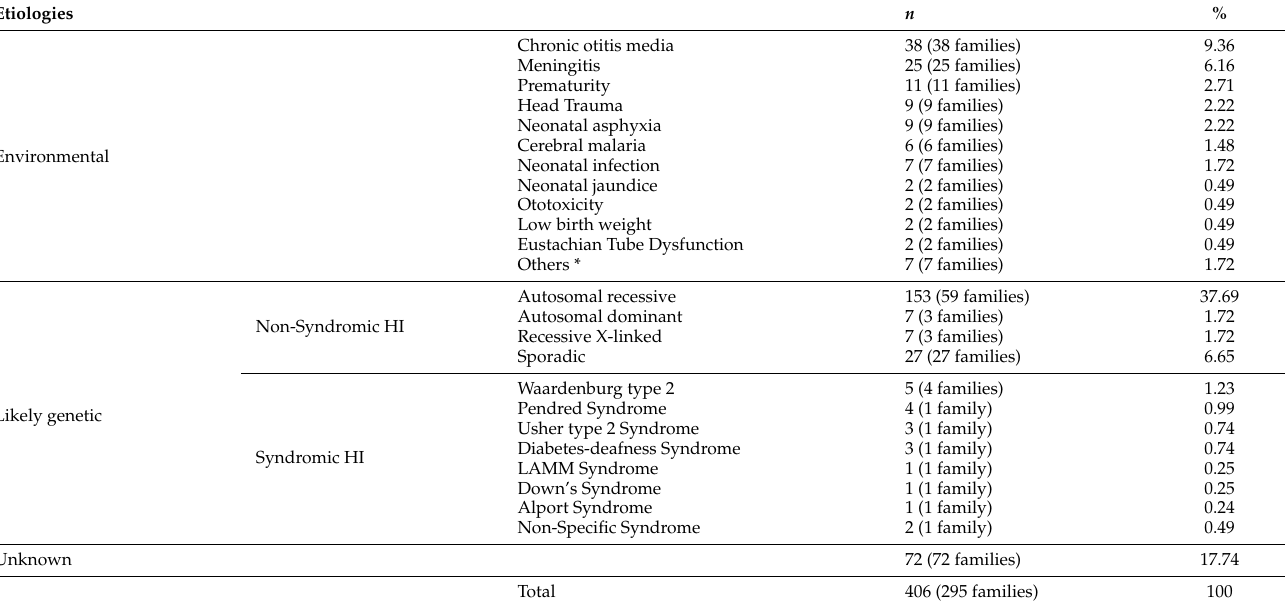
Table 3. Etiologies of Childhood Hearing Impairment in Senegal.